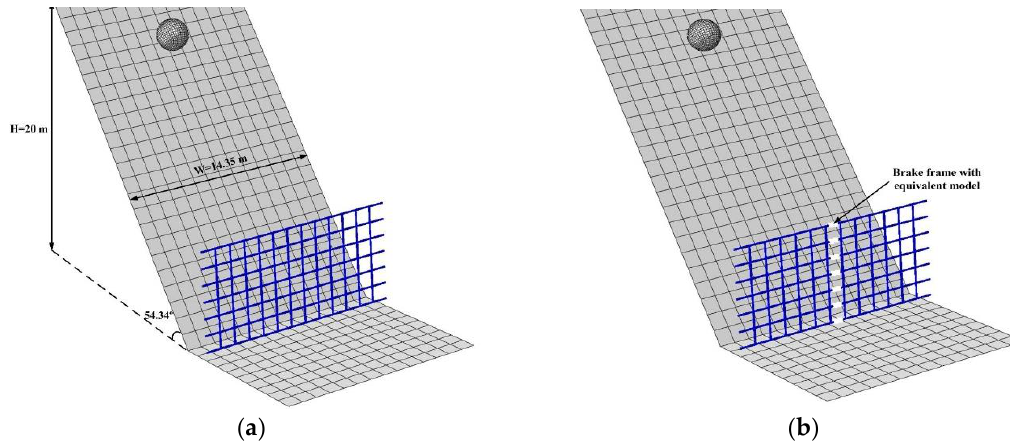
Figure 10. Numerical models with and without using brake frames, ( a ) without brake frame; and ( b ) with brake frame.